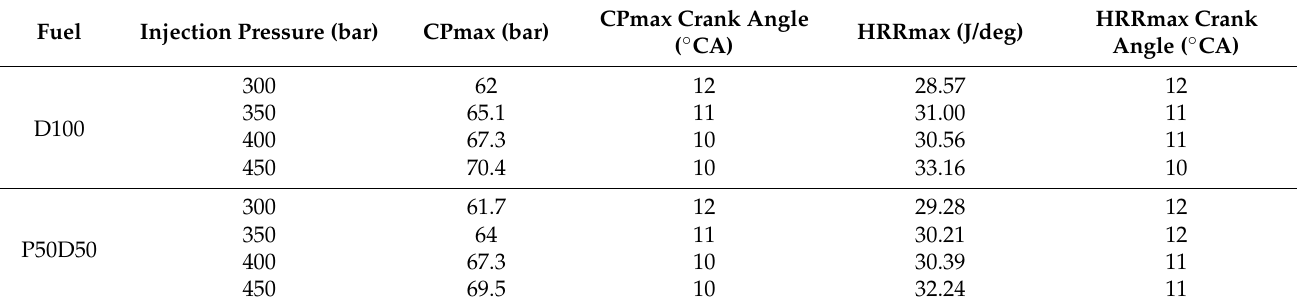
Table 5. Maximum values of CP and HRR and their corresponding crank angles (without EGR).